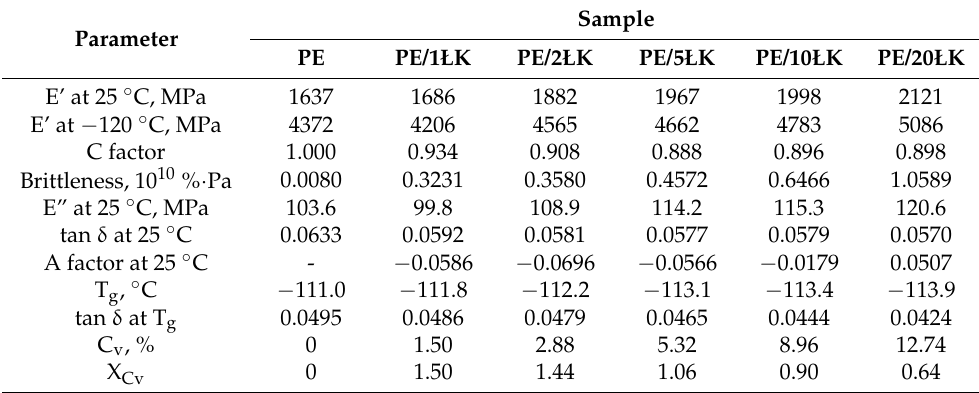
Table 1. Results of the dynamic mechanical analysis of prepared